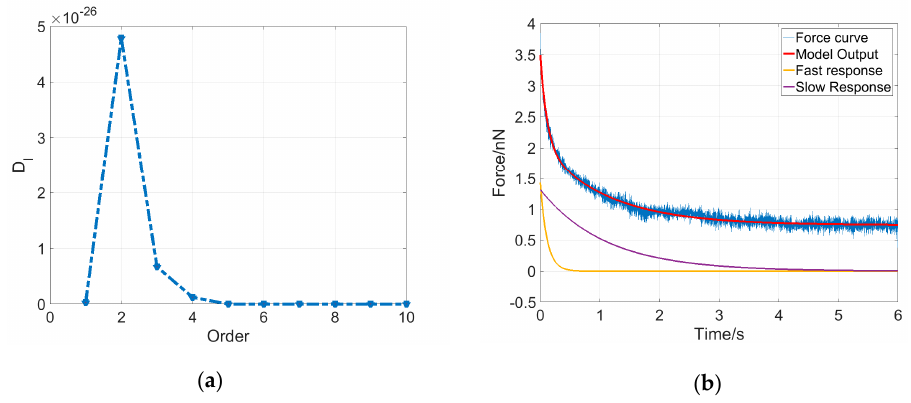
Figure 4. Determination of the system order and parameters of an MCF-7 cell. ( a ) D l series of an MCF-7 cell. As l increases, D l reaches the maximum at l = 2 and then decays to 0; ( b ) The model output of the cell system (red) of second order with estimated parameters fits the experimental force curve (blue) very well. The two exponential decay components represent the fast response (yellow) and slow response (purple) of the characteristics and the system dynamics of the MCF-7 cell.